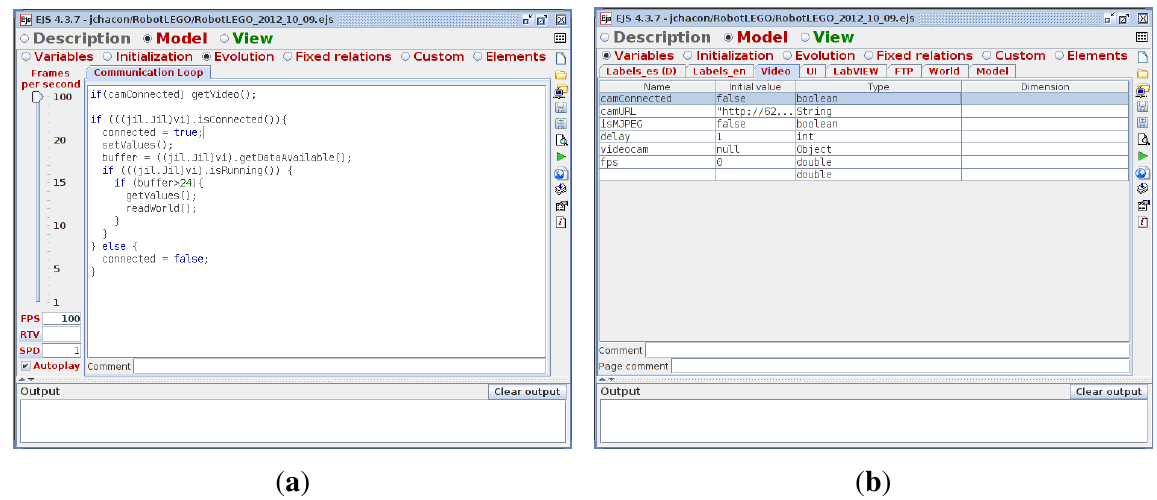
Figure 6. Definition of the model in EJS. ( a ) Subpanel Evolution of EJS; ( b ) Subpanel Variables of